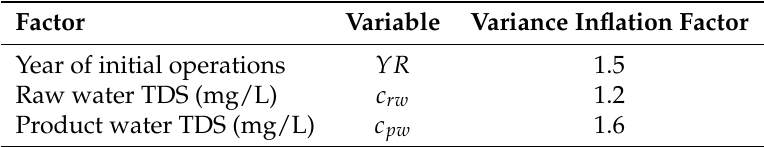
Table A2. Variance inflation factors (VIF) for variables considered in the municipal-scale multiple linear regression model show no multicollinearity where VIF > 10. Values have been rounded to two significant figures.